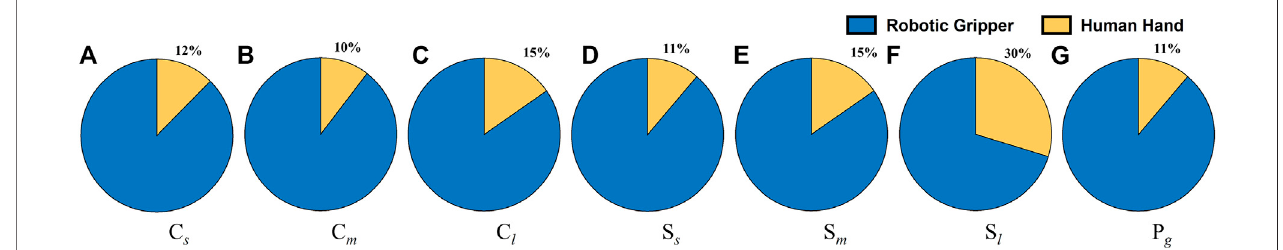
FIGURE10| Thispiechartpresentsacomparisonofthetimetakenbytheroboticgrippersagainsthumanhandsforexecutingtaskswithobjectsofvaryingshapes and sizes. C, S and P stand for Cylinders, Squares and Pegs respectively. The Subscripts s, m, l, g denote small, medium, large, and grooved objects